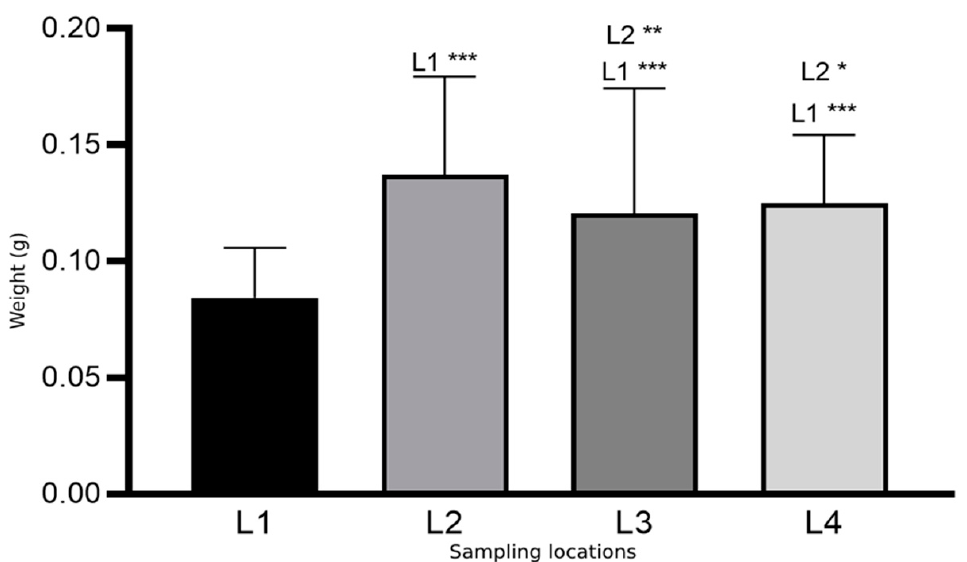
Figure 3. Weight means values of extracted cocoons from artificial nests situated at different locations. Asterisks indicates statistically significant differences: L1 vs. L2, L3, L4; L2 vs. L3, L4; * p < 0.05, ** p < 0.001, *** p < 0.0001; mean ± SD. Adult specimens of O. bicornis differ in weight at emergence (Figure 4), particularly those significantly lightweight originating from L4, in comparison with those from L1, L2 and L3 (F = 97.45; p < 0.0001). The mean weight values of cocoons extracted from live bees increased as follows: L4 = 0.053 ± 0.007 g, L1 = 0.075 ± 0.006 g, L2, L3 = 0.75 ± 0.010